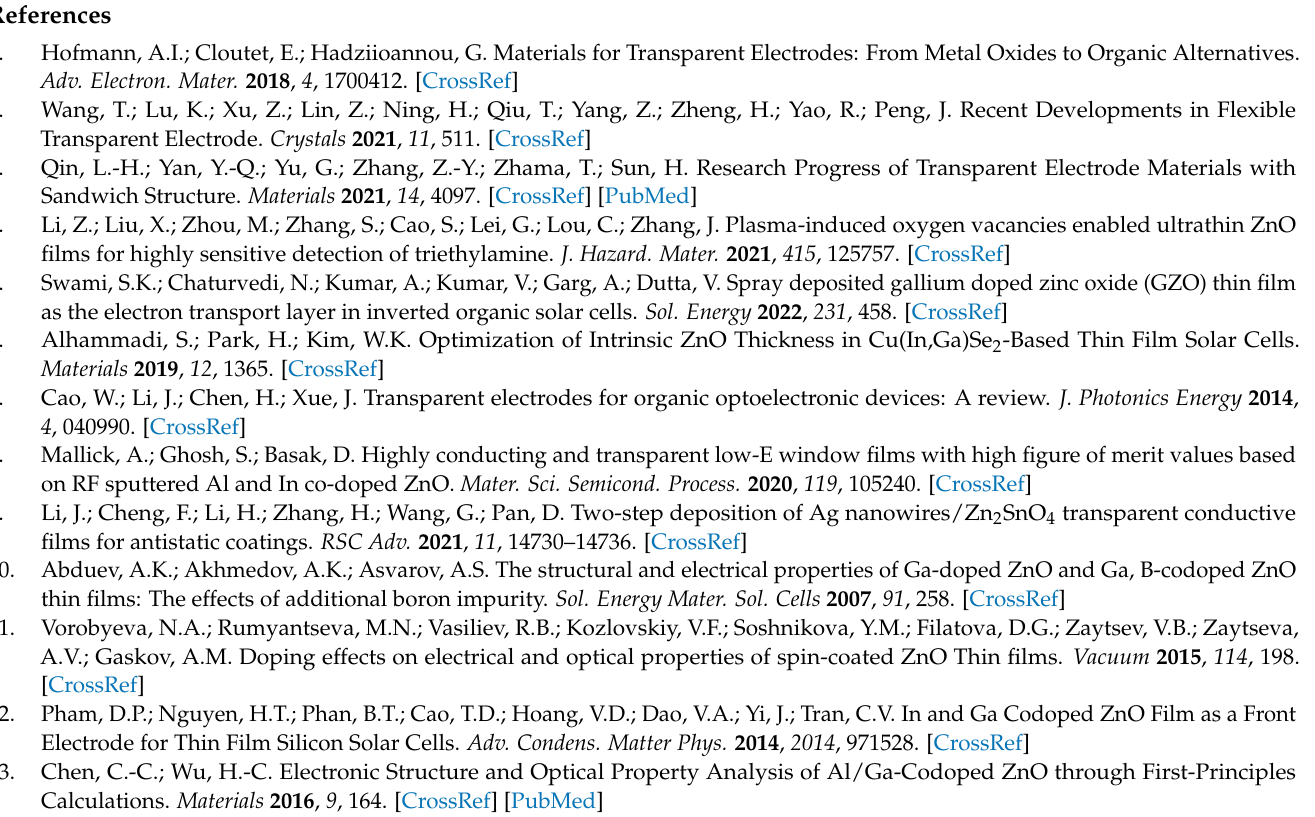
Figure S2: SEM micrographs of 2AZO ( a ), 2GZO ( b ), and 2A2GZO ( c ) thin films deposited at sub-strate temperature of 300 ◦